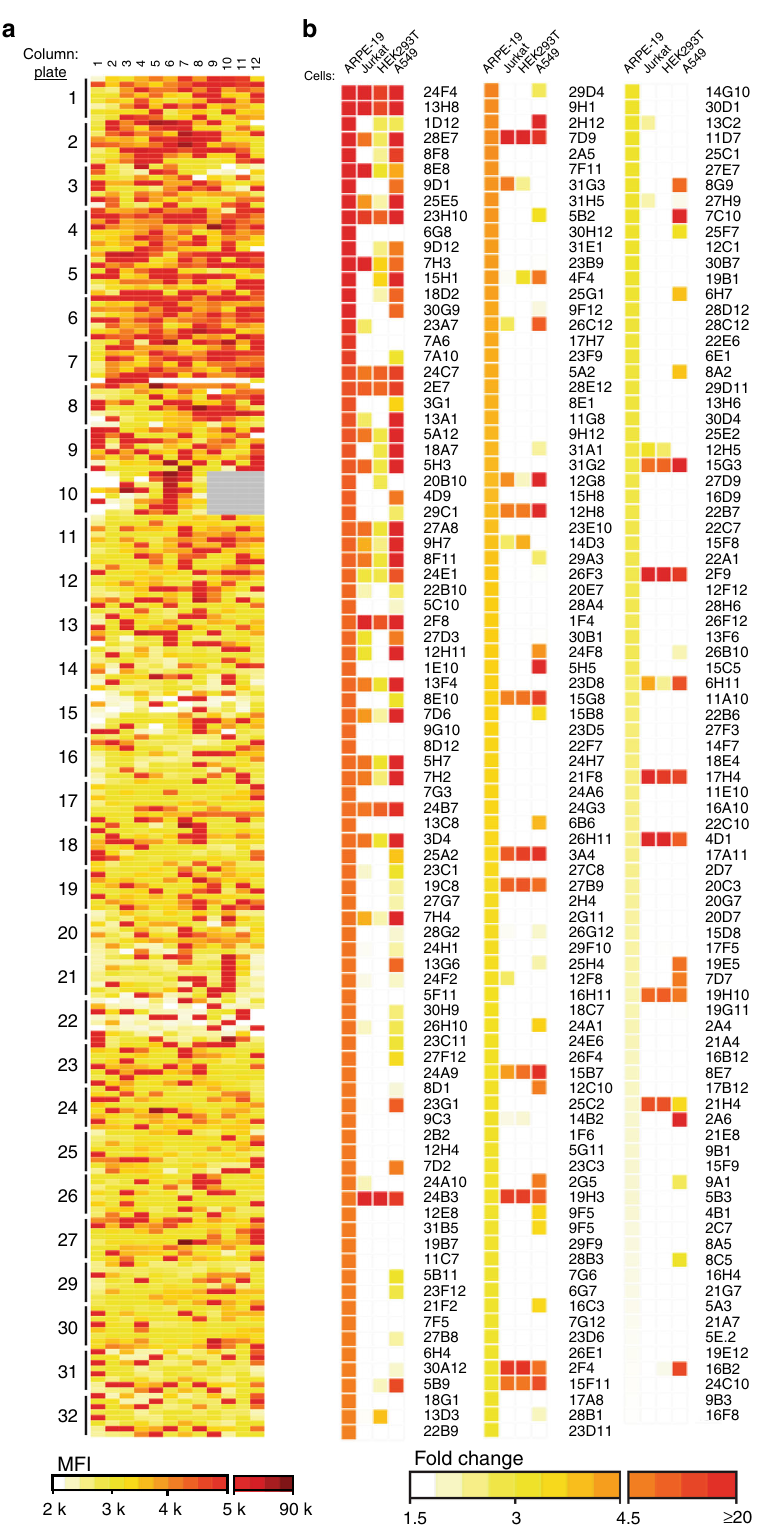
Fig. 2 High-throughput screening for cell-surface binding clones. a Hybridoma supernatants across 32 96-well plates were incubated with ARPE-19 cells, with binding detected through fl ow cytometry. Clones that bound with mean fl uorescent intensity (MFI) two fold over background (~5 k) or higher were designated as cell-surface binders. Darkening red hues are relative to increasing MFI. Wells without clones are represented in gray. b Supernatant from ARPE-19 cell-surface binders was subjected to high-throughput fl ow cytometry using against Jurkat, HEK293T and A549 cells to evaluate speci fi city. Fold change of MFI was determined on a cell-type basis compared to a known non-binder (anti-gH 5C3) and is represented by darkening red hues relative to its